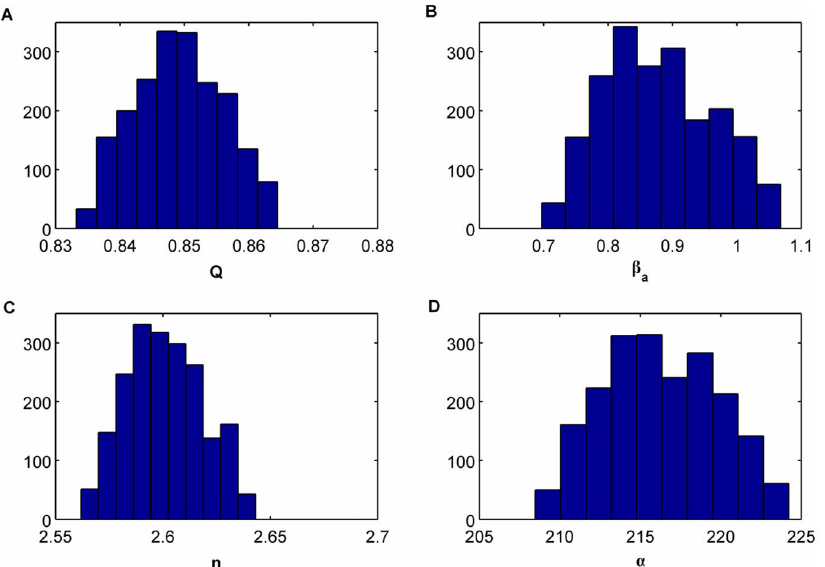
Figure 6(A–D) shows the output (i.e. the accepted particles) of the ABC SMC algorithm as scatterplots of some of the two- dimensional parameter combinations, where we have information of different populations in the same plot. As we iterate the algorithm we obtain populations that are more dense around the desired values, as shown in these plots, where the particles from the prior are represented in blue, particles from population 2 in green, particles from population 4 in light blue, population 6 in